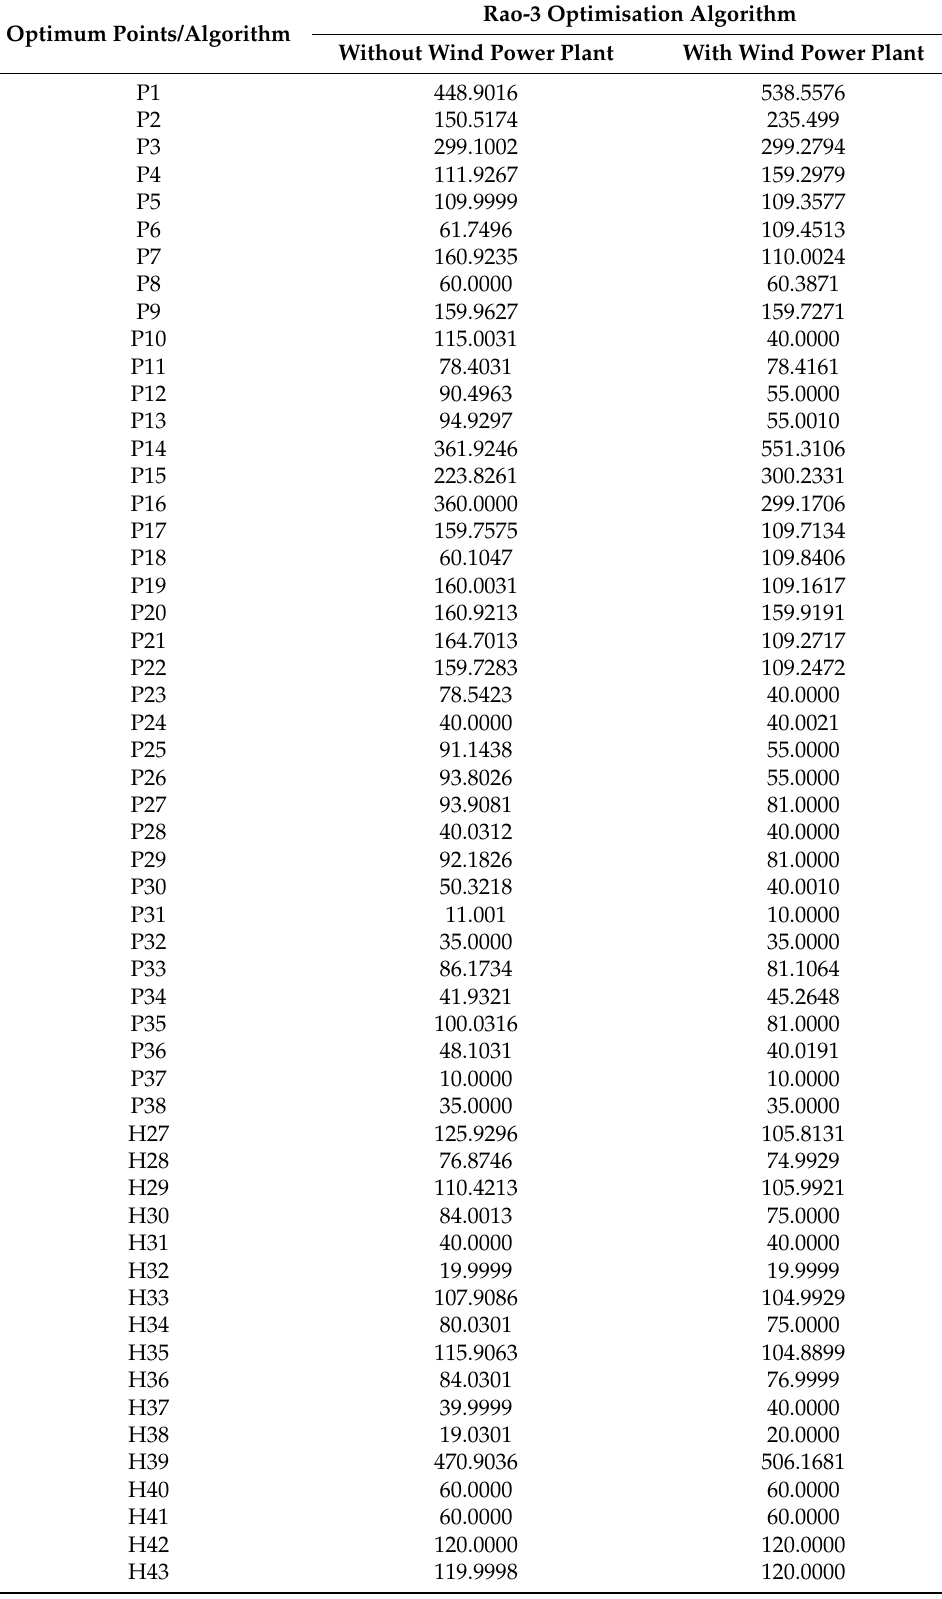
Table 1. Optimal distribution of power–heat production considering VPL